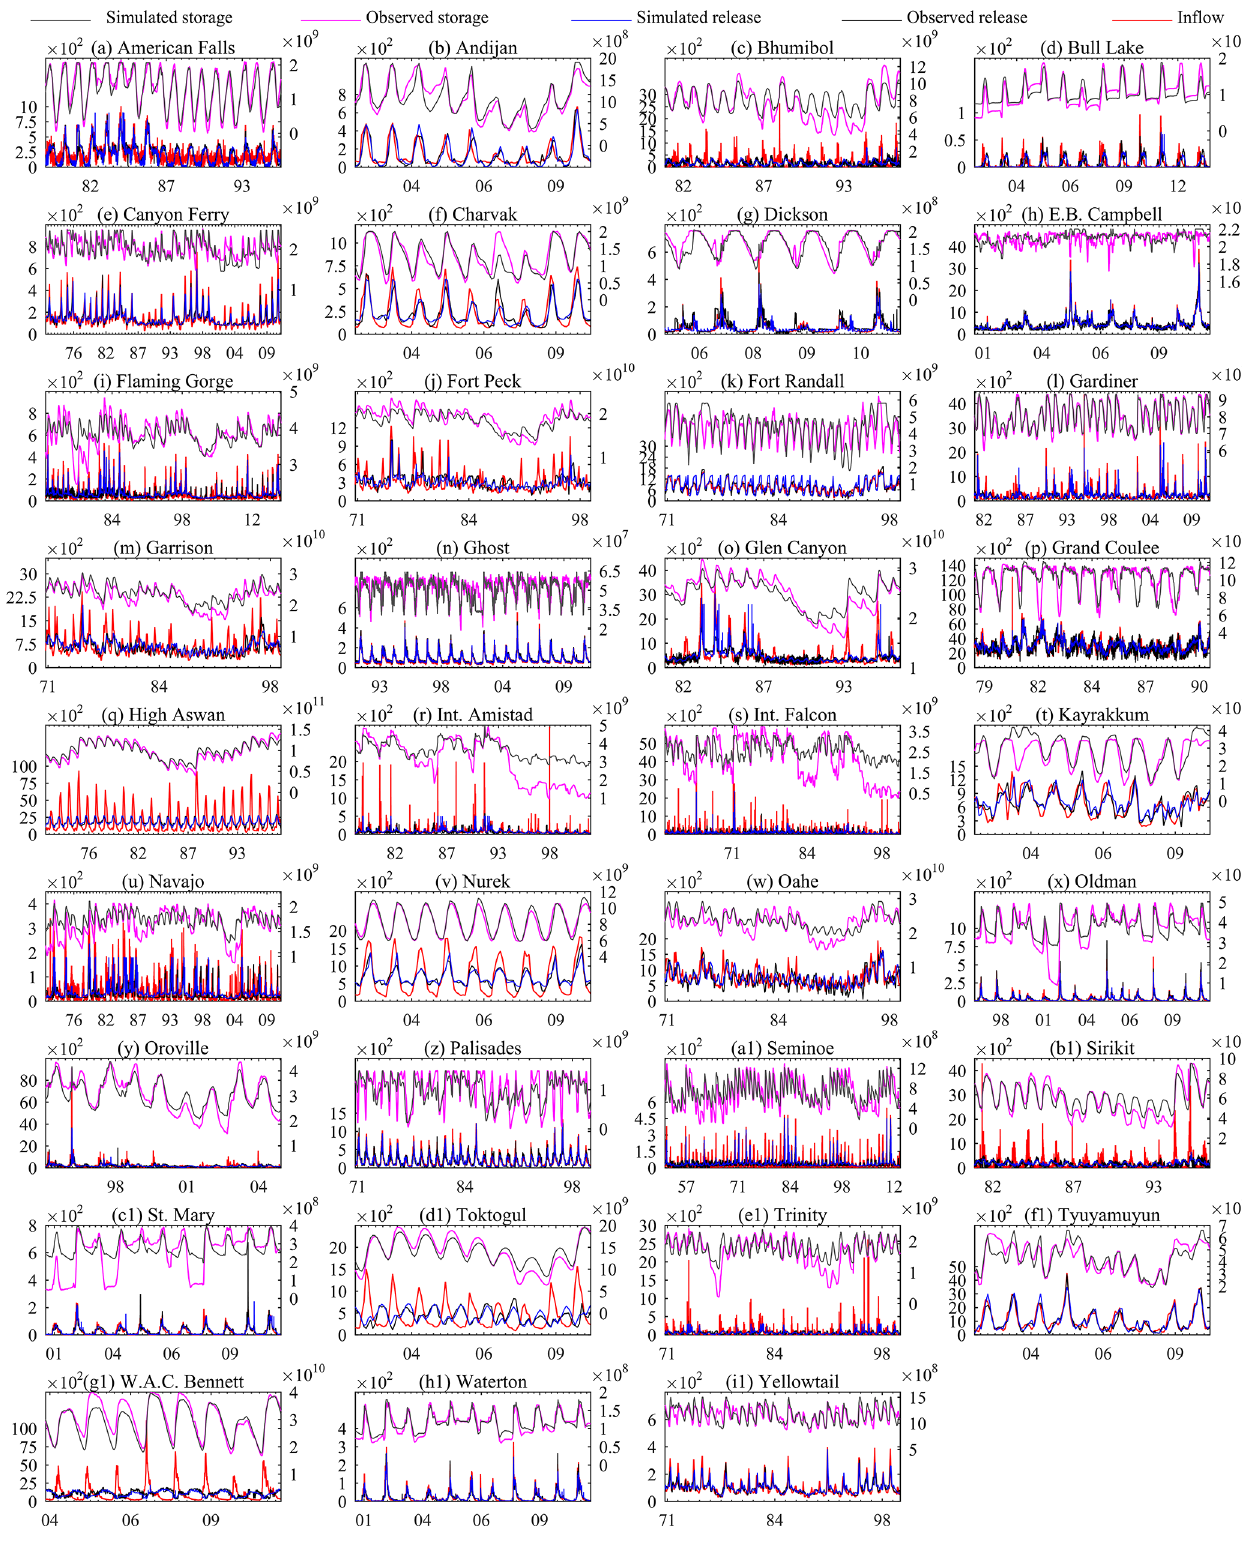
Figure 6. Daily and monthly reservoir simulations using the DZTR model with a generalized parameterization; x axes show month and year, the primary y axes show release (m 3 s − 1 ), and the secondary y axis shows storage (m 3 ).